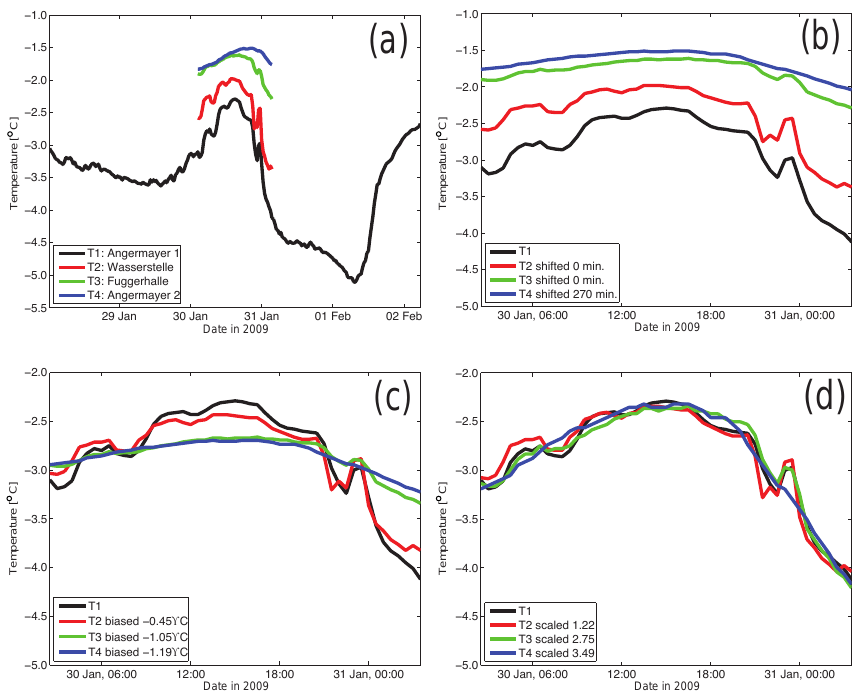
Figure 6. Raw data (a) of loggers T2, T3, and T4 were shifted in time relative to logger T1 to be correlated (b) . The time period shown in (a) corresponds to the search window, while a time span of 51 samples was used for correlation analysis and to adjust temperature biases and scale factors. In a second step (c) the temperature biases were applied to loggers T2, T3, and T4; and finally (d) the temperature variations at loggers T2, T3, and T4 were scaled to fit those at logger